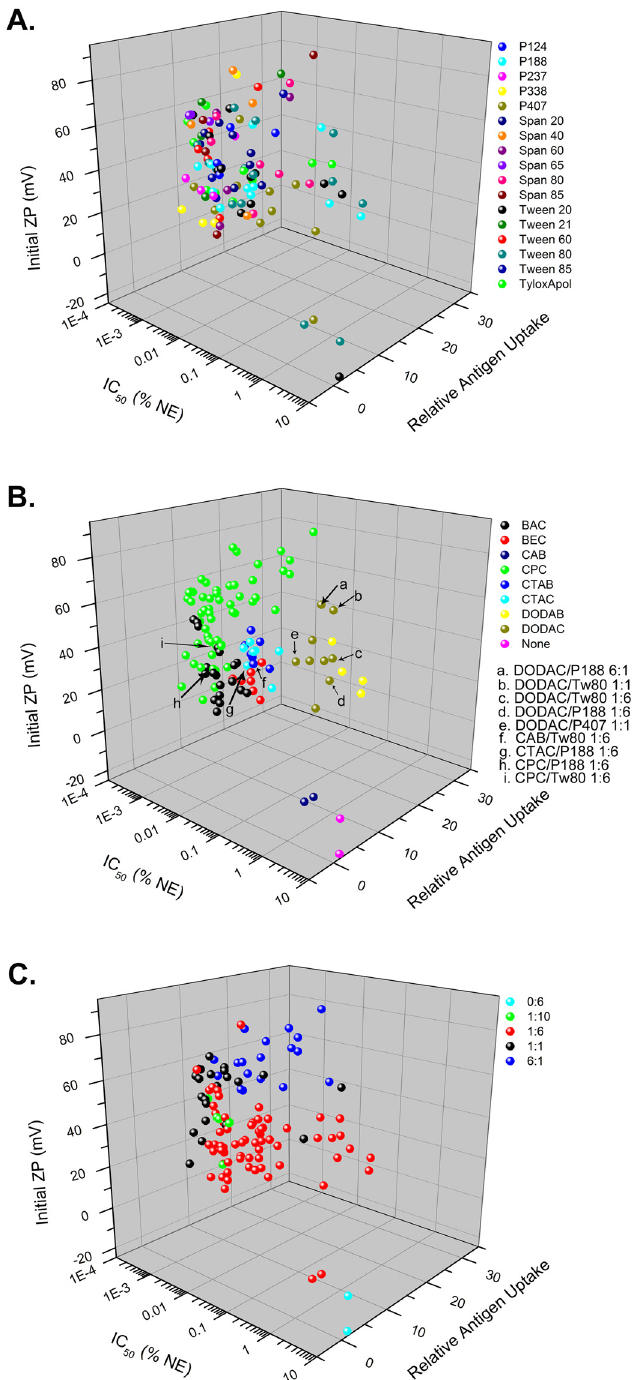
Fig 7. 3D scatter plots of in vitro assay results for cytotoxicity (IC50), antigen uptake, and ZP init . Scatter plots are colored by (A) nonionic surfactant, (B) cationic surfactant, or (C) cationic:nonionic ratio. Formulations further evaluated in vivo are indicated by